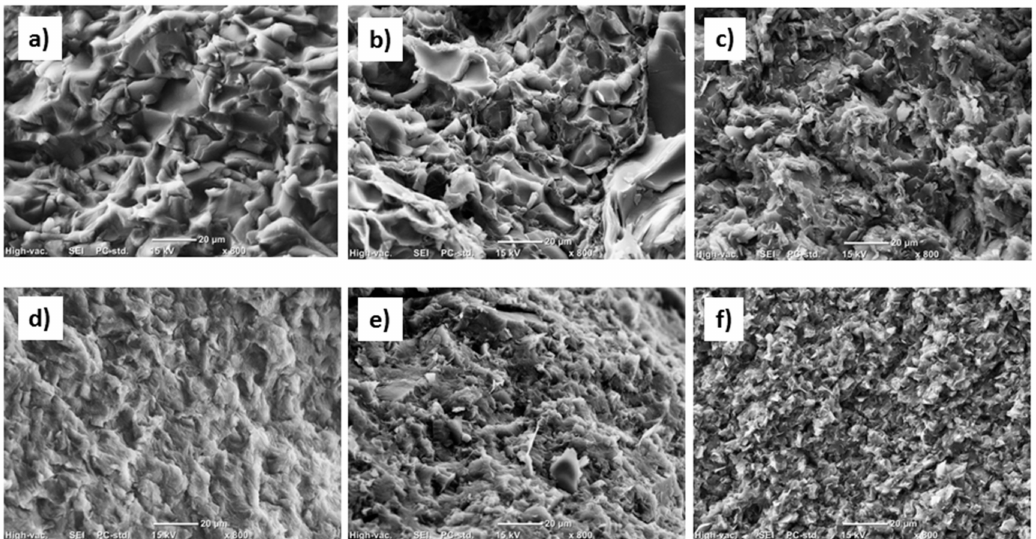
Figure 7. Scanning electron microscopy (SEM) images of investigated samples:( a ) PW; ( b ) EG–PW Stirred; ( c ) EG–PW US30; ( d ) CW; ( e ) EG–CW Stirred; ( f ) EG–CW